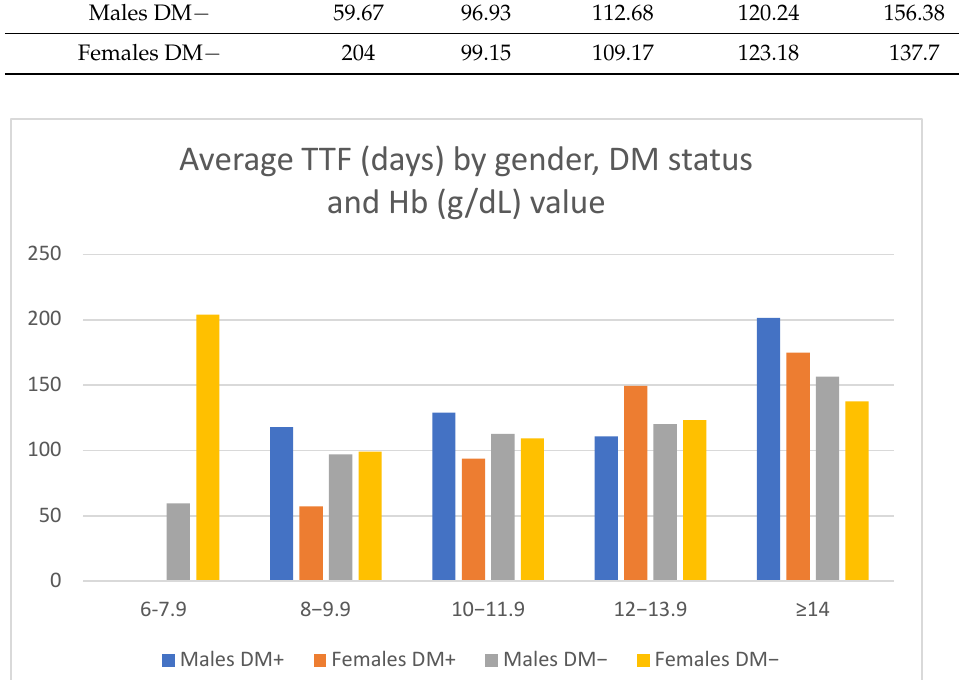
Figure 8 . Average TTF by sex, DM status, and Hb value . Figure 8. Average TTF by sex, DM status, and Hb value.